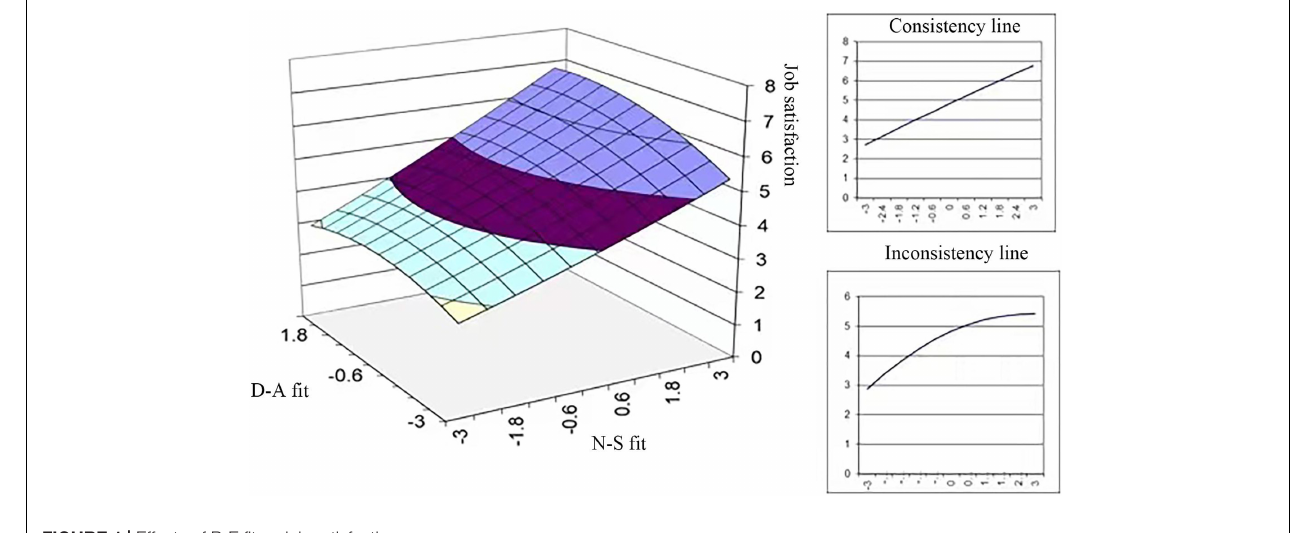
FIGURE 1 | Effects of P-E fit on job satisfaction.